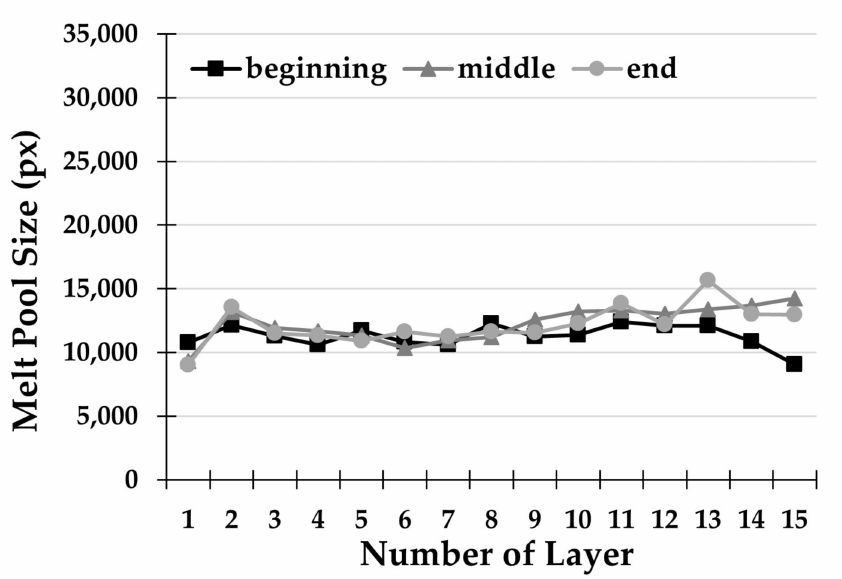
Figure 7. Melt pool size for each deposited layer with strategy